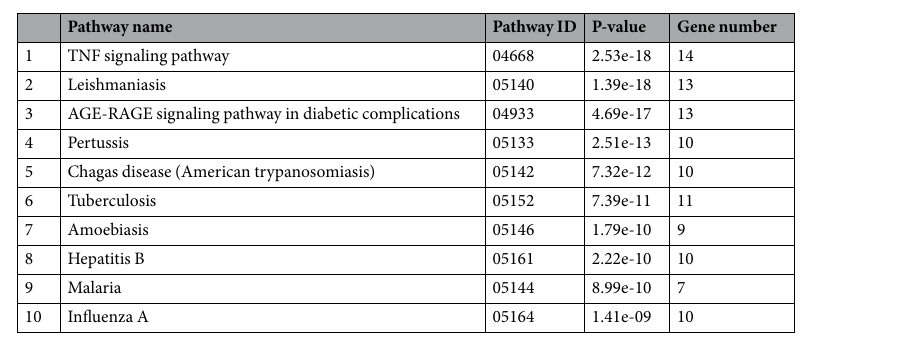
Table 4. Top 10 pathways enriched with genes associated with SCI